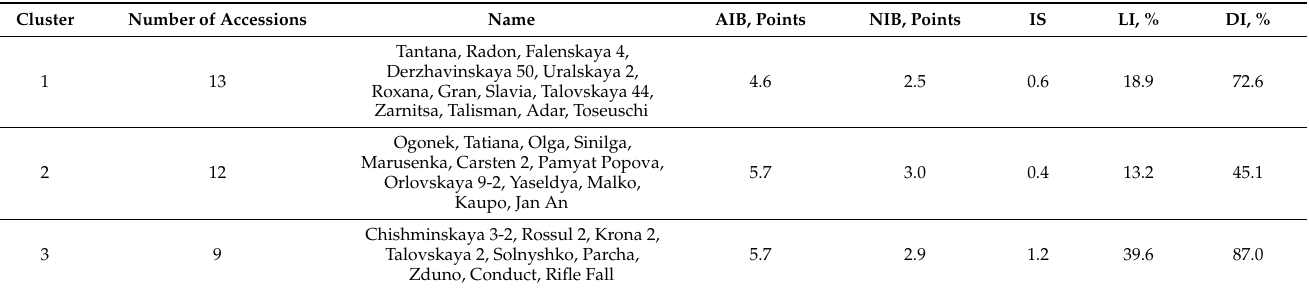
Table 5. The characteristics of clusters arranged based on the parameters of snow mold damage of 34 rye accessions assessed under a natural infection background (NIB) and an artificially-enriched infection background (AIB) in the field, as well as under laboratory conditions following Microdochium nivale infection using a detached leaf assay yielding index susceptibility (IS), mean percent of leaf infestation (LI), and mean percent of disease incidence